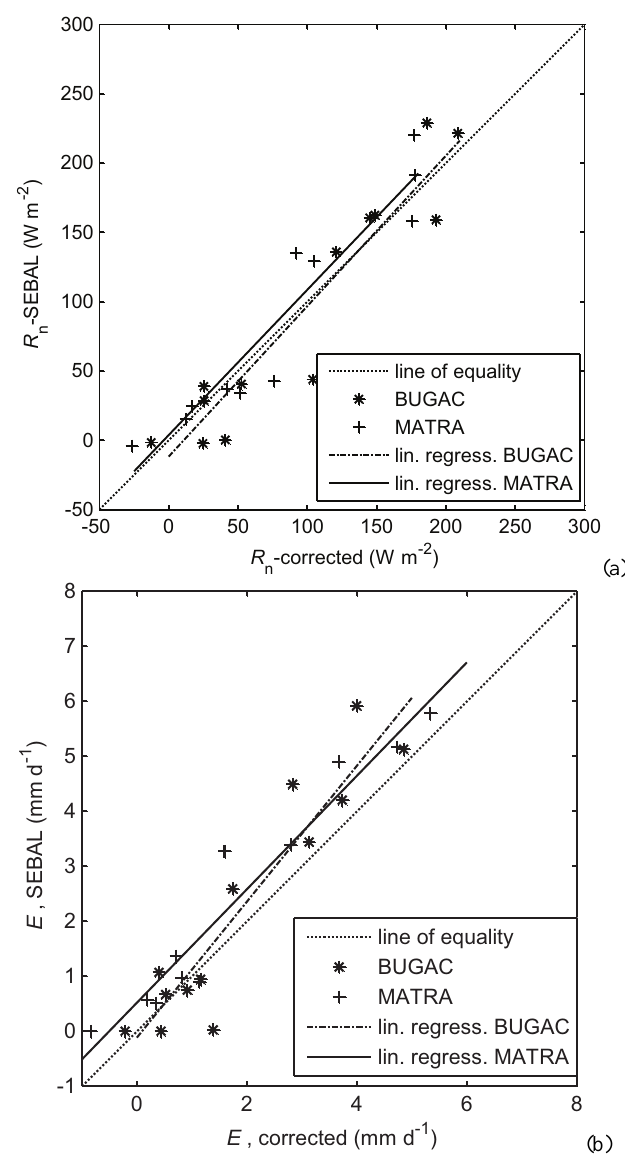
Fig. 4. (a) Correlation between groundbased daily R n and R n - SEBAL. (b) Correlation between groundbased corrected E and E - SEBAL. The groundbased energy fluxes have been obtained from the meteorological towers Matra and Bugac, of which the energy balances have been closed proportional to the Bowen ratio. The SEBAL observations have a spatial resolution of